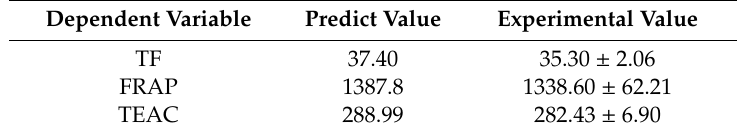
Table 4. Experimental data of the validation of predicted values at optimal extraction